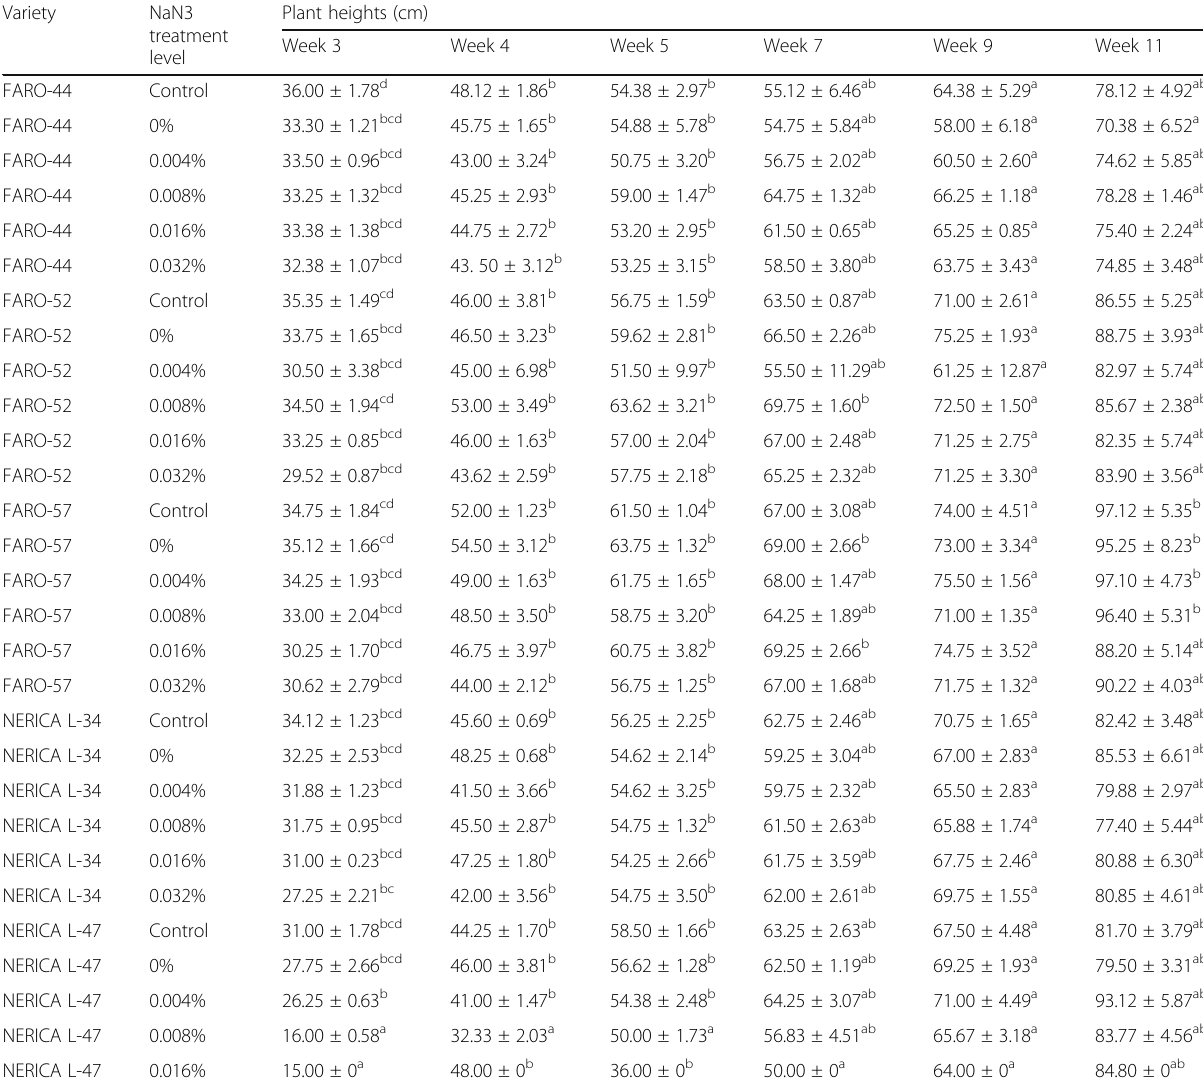
Table 3 Plant heights of the five rice varieties (CM)